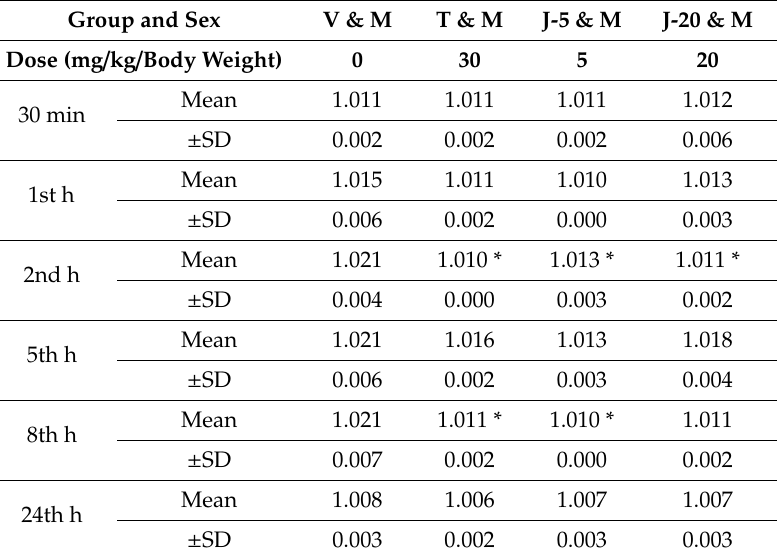
Table 1. Summary of urine specific